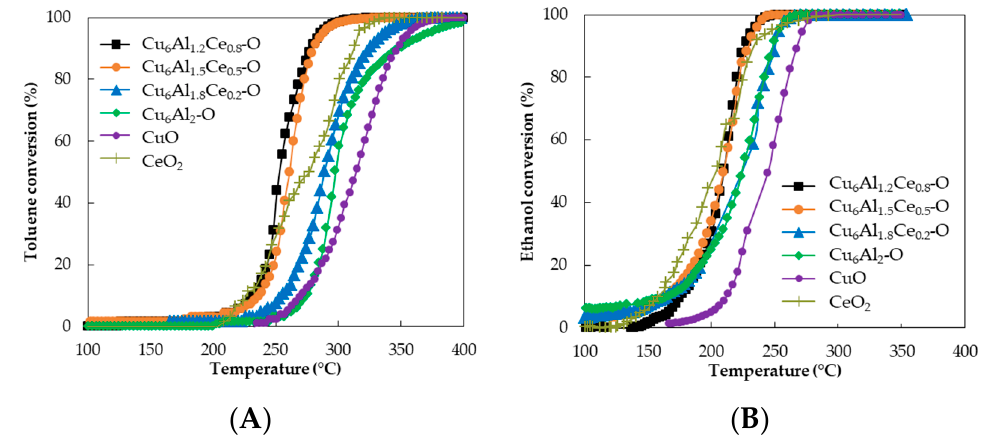
Figure 9. Light-o ff curves of toluene ( A ) and ethanol ( B ) total Figure 9. Light-off curves of toluene ( A ) and ethanol ( B ) total oxidation.